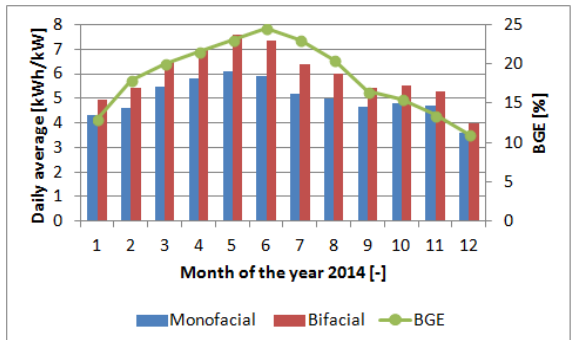
Fig. 1. Average daily energy yields and BGE, obtained in the tests conducted by the authors of the paper